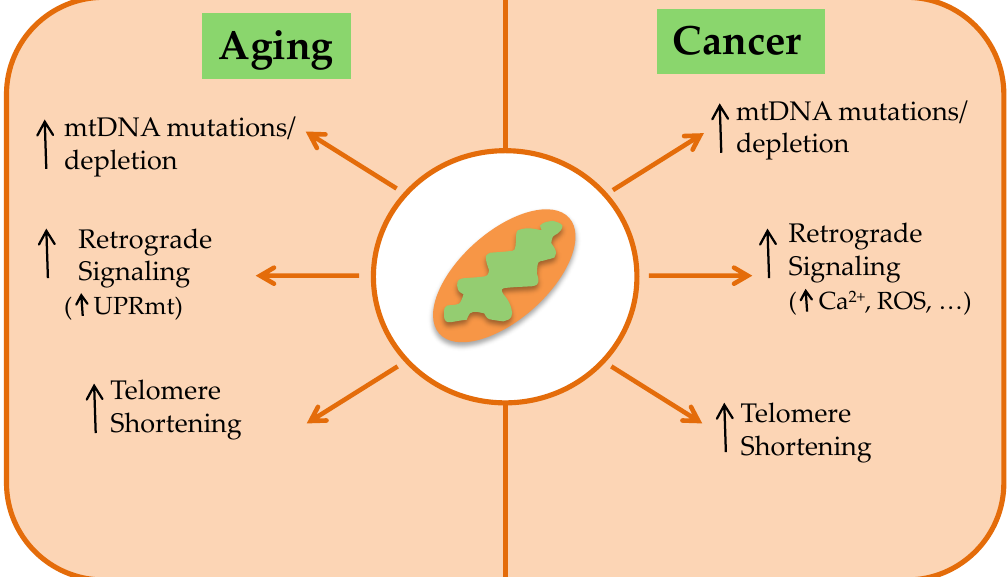
Figure 1. Mitochondrial dysfunction in aging and cancer. Aging and cancer share common mechanisms that include an alteration of the mitochondrial genome (mtDNA), activation of mitochondria-to-nucleus signaling pathways (retrograde signaling; see text for details) and telomere shortening. The latter is the biological clock of the cells, and beyond a limit, would cause cell cycle arrest and apoptosis, preventing the unlimited replication of normal cells. In cancer cells, expression of the telomerase hTERT would prevent excessive shortening of telomeres. Recent evidence points to mitochondrial dysfunction as a regulator of telomere